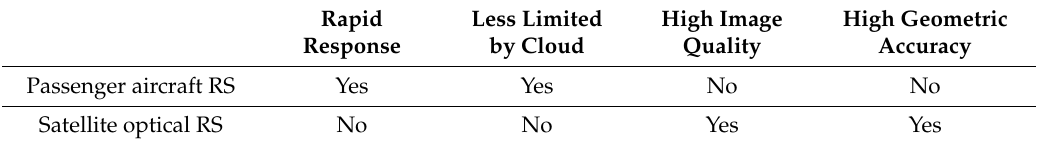
Table 5. Comparison between passenger aircraft remote sensing (RS) and satellite optical RS.